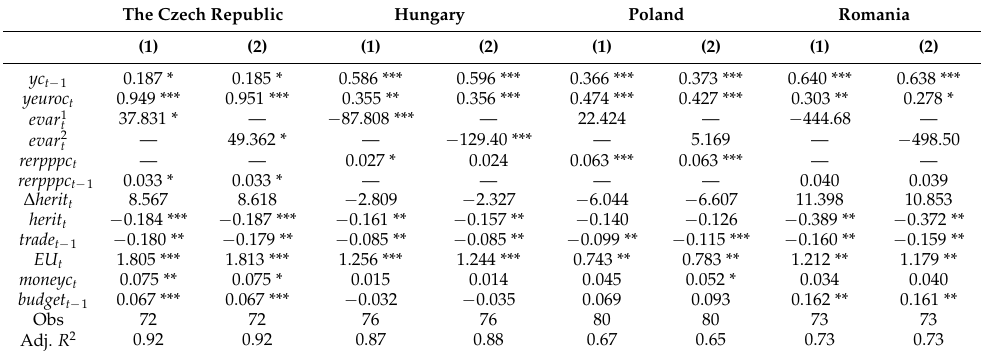
Table 9. Regression results for cyclical components of output (extended model-I).